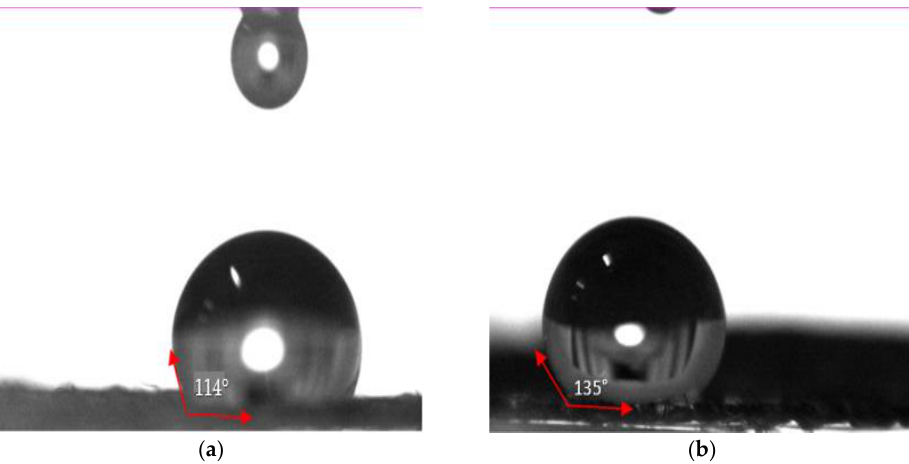
Figure 8. Water contact angles measured from water droplets deposited on the surface of the untreated fabric ( a ) and PUPXC6PW-treated fabric ( b ).